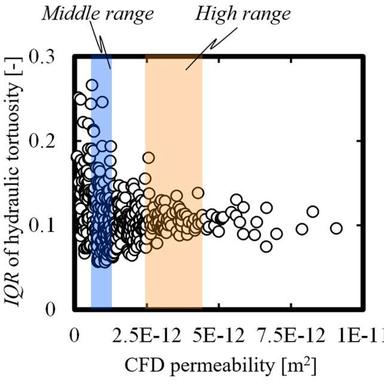
IQR of hydraulic tortuosity versus CFD permeability.